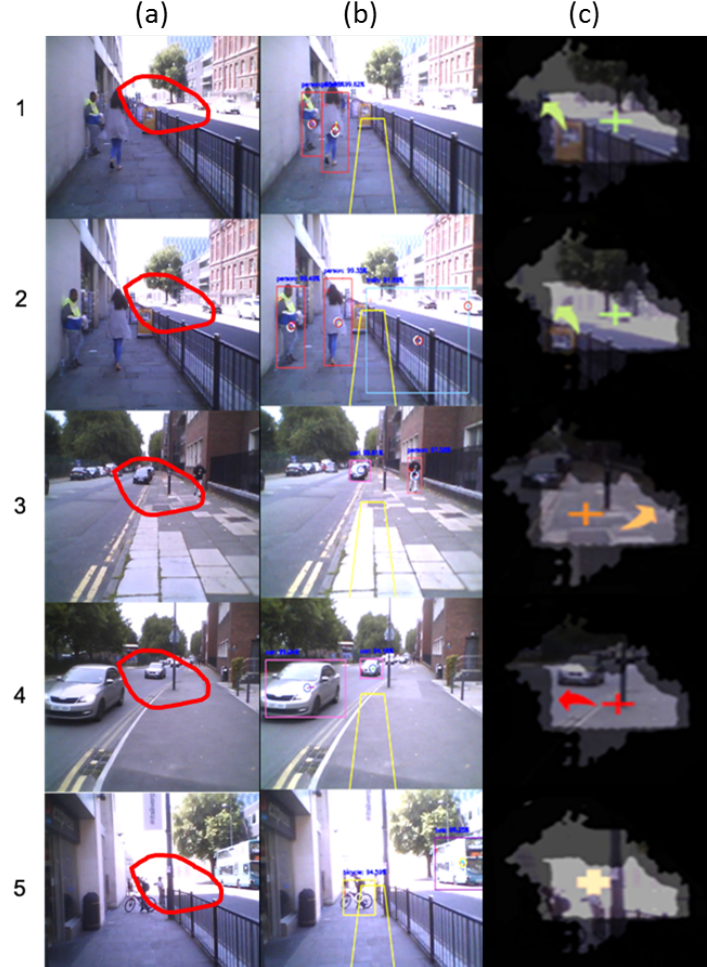
Figure 12. Examples from the feedback generation stage for the defined hazard